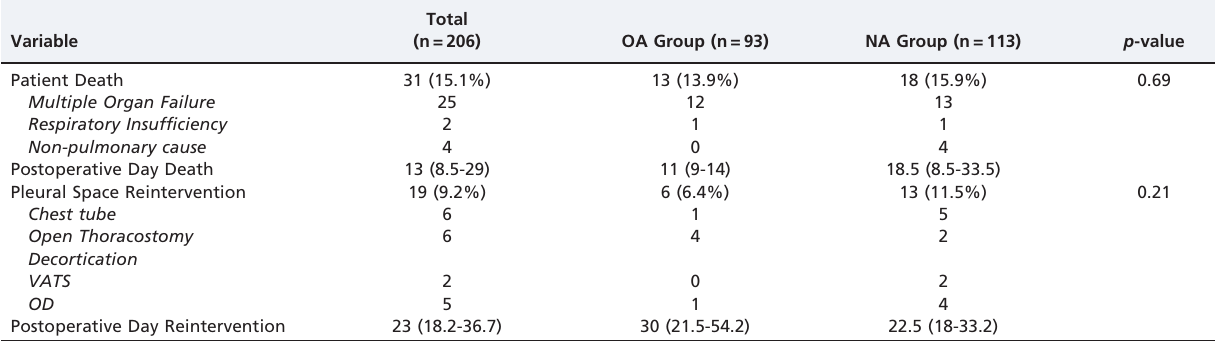
Table 3 - Causes of death and new pleural procedures performed as reinterventions.